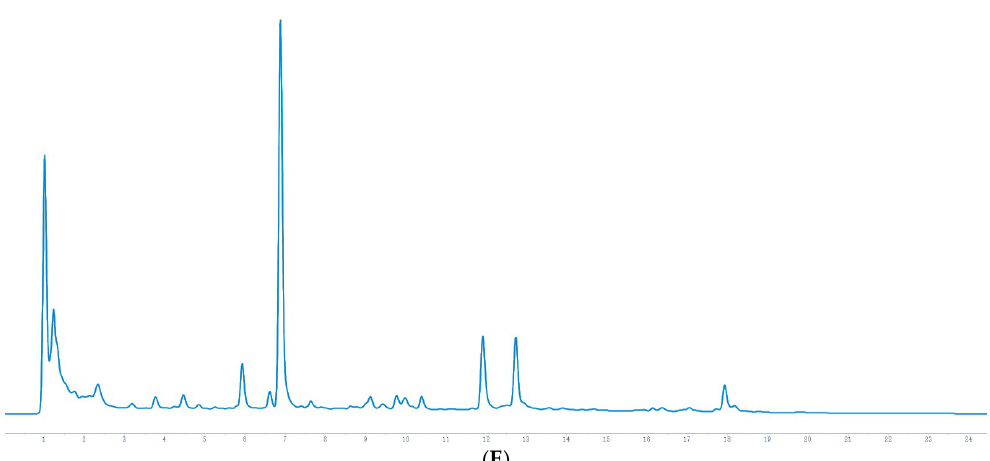
Figure 2. HPLC chromatograms of mixed reference substances and Jianqu samples with different fermentation times. ( A ). Mixed reference solution ( B ) 0 h sample ( C ) 36 h sample ( D ). 72 h sample ( E ) 96 h sample 1. naringenin 2. Hesperetin